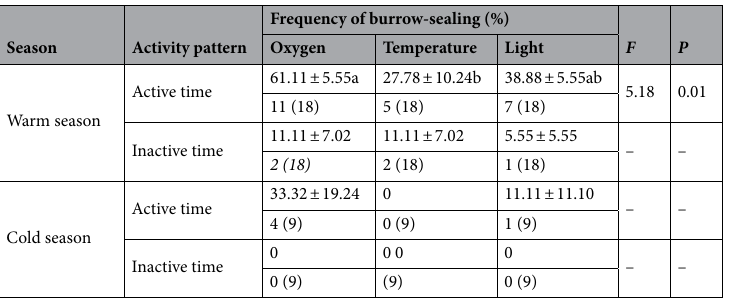
Table 3. Burrow-sealing frequency in the field under different treatments. Italic numbers not in brackets denote the number of burrow-sealing events, while those in brackets are the number of experiments. Different lowercase letters indicate a significant difference ( P < 0.05), while the same lowercase letter indicates a non- significant result.